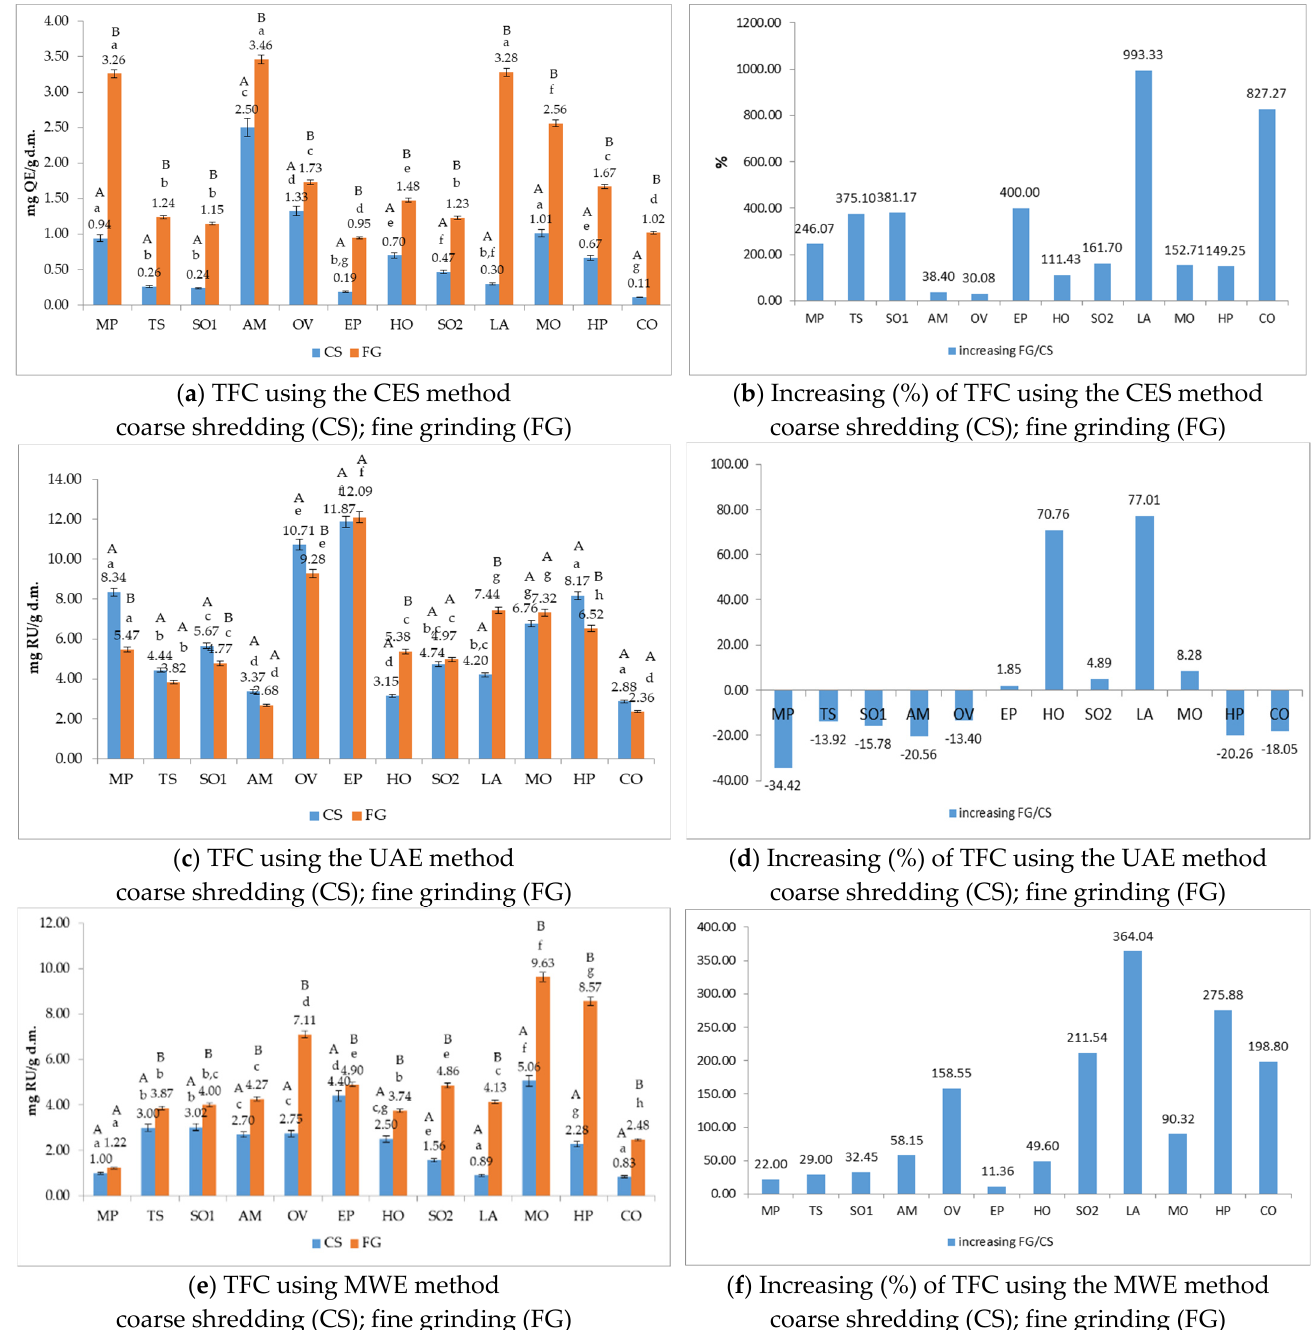
Figure 6. TFC for CS/FG samples extracted by CES, UAE, and MWE methods. According to the t -test, the different lower-case letters (a–h) represent the significant differences ( p < 0.05) between samples obtained by the same shredding method. The different capital letters (A, B) represent the significant differences ( p < 0.05) between samples from the same plant obtained by different shredding methods.